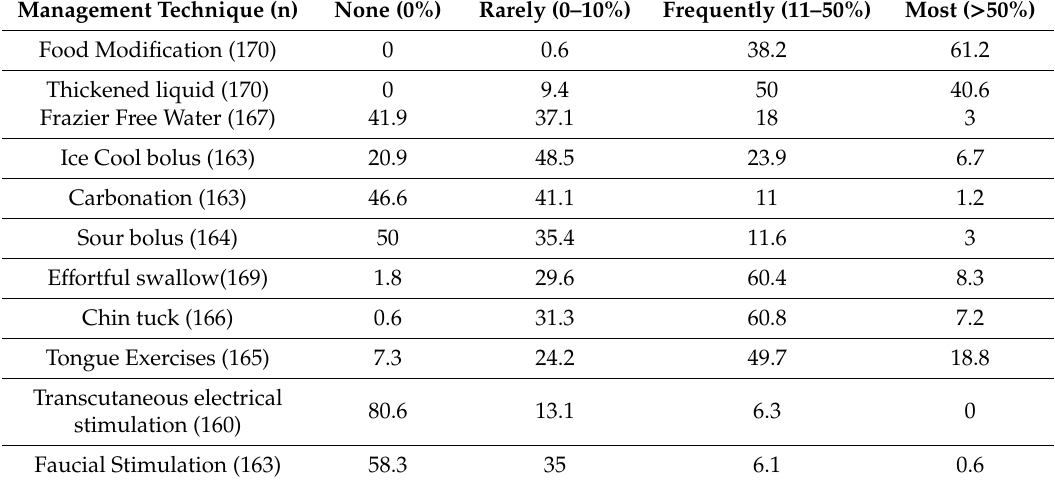
Table 3. Frequency of use for Management Techniques (as a percentage of the